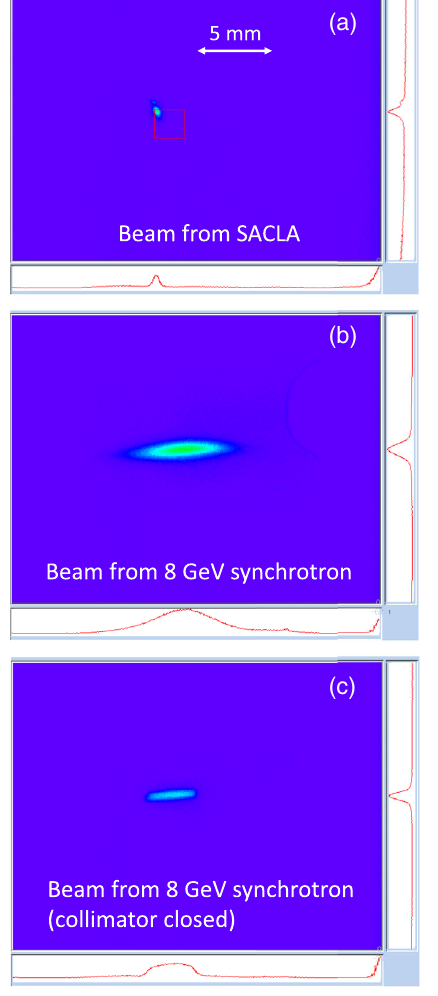
FIG. 5. Transverse beam profiles observed on a screen monitor close to the beam injection point of the SPring-8 storage ring. Injected beams from SACLA (a) and the 8 GeV synchrotron (b, c) are shown. In (c), a collimator installed at the synchrotron exit is closed to improve injection efficiency.